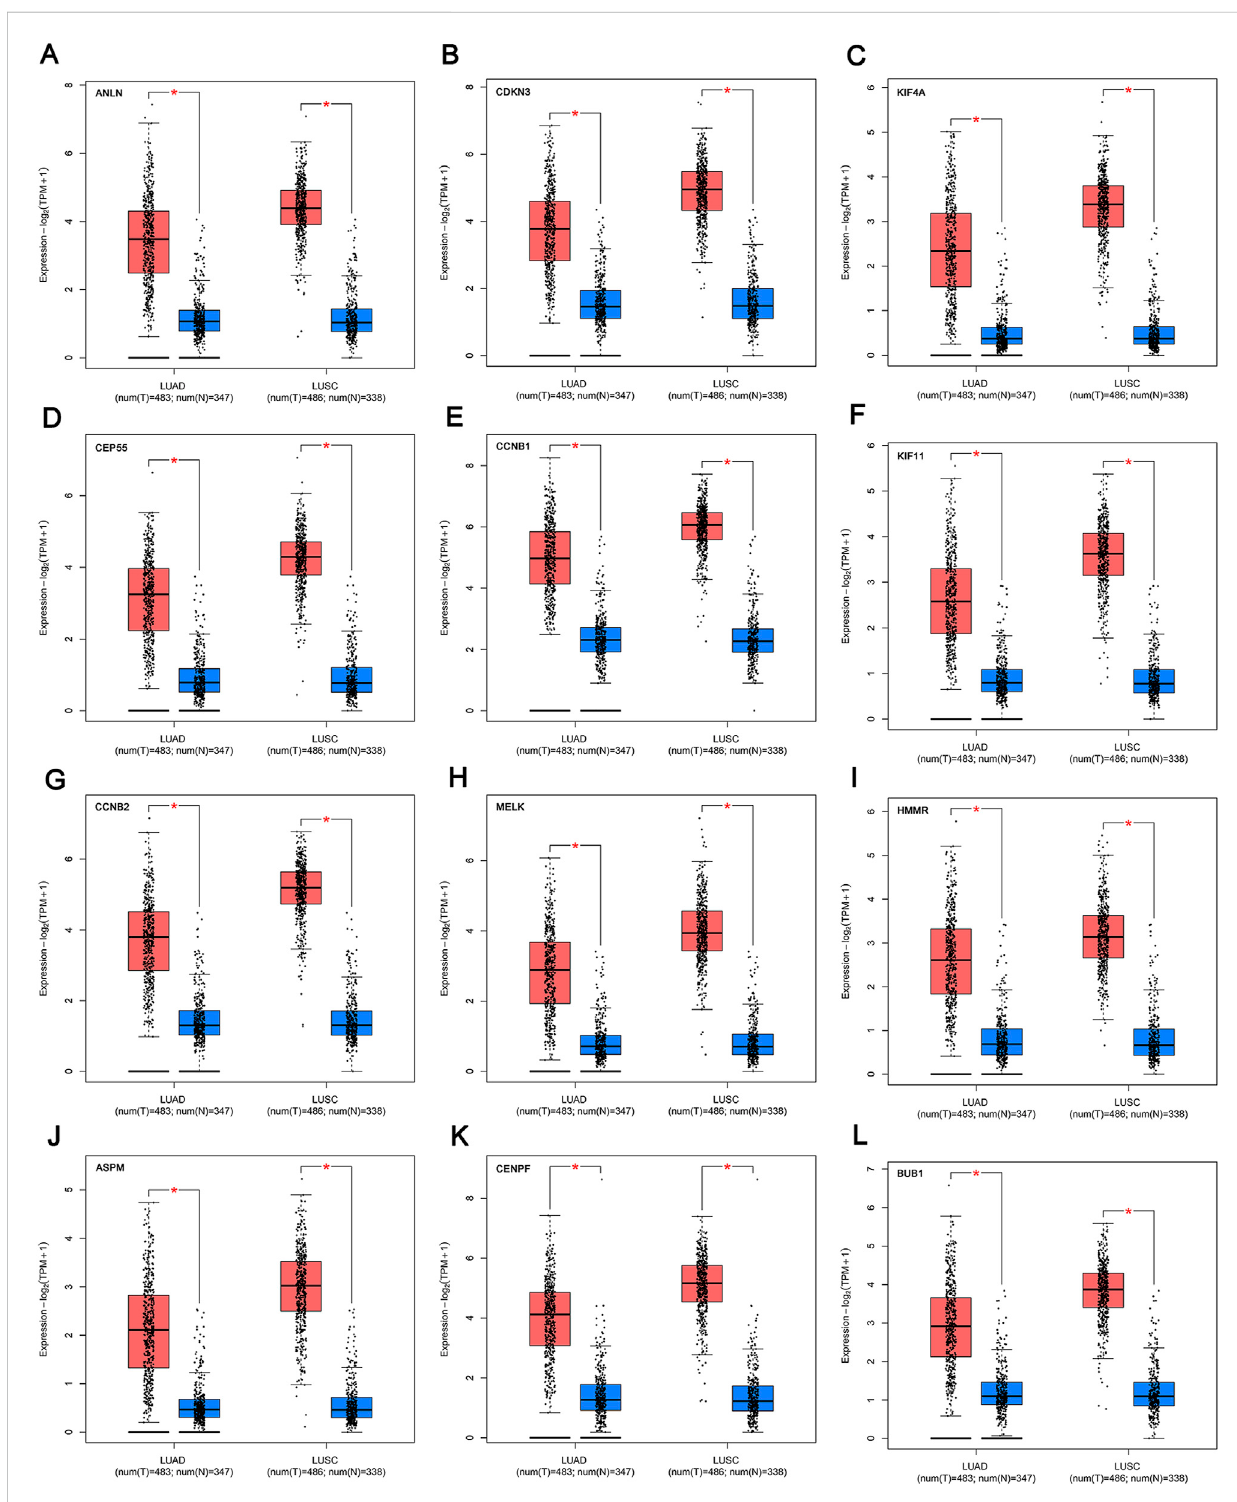
FIGURE 5 mRNAexpressionofthekeygenes (A-L) inNSCLCand normalsamplesfromTCGAandGTEx.* p < 0.01.Theredbox referstothetumorgroup, blue box refers to normal group. NSCLC, non-small cell lung